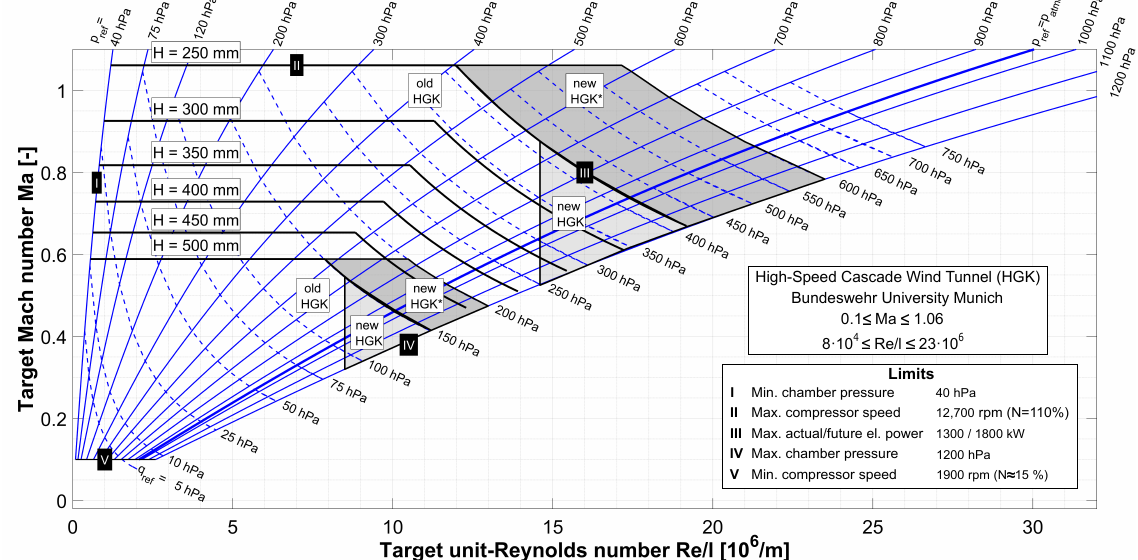
Figure 5. Performance map of the HGK for different test section heights H over the facility’s static and dynamic pressure range p ref (solid blue) and q ref (dashed blue), respectively (at T t = 30 ◦